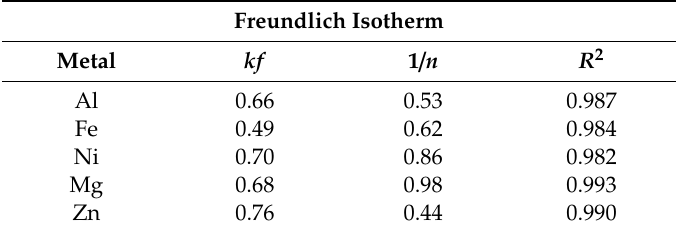
Table 2. Parameters of the Freundlich isotherm model for ion exchange of metal on AmberliteIR-120. Freundlich Isotherm Metal kf 1 / n R 2 Al 0.66 0.53 0.987 Fe 0.49 0.62 0.984 Ni